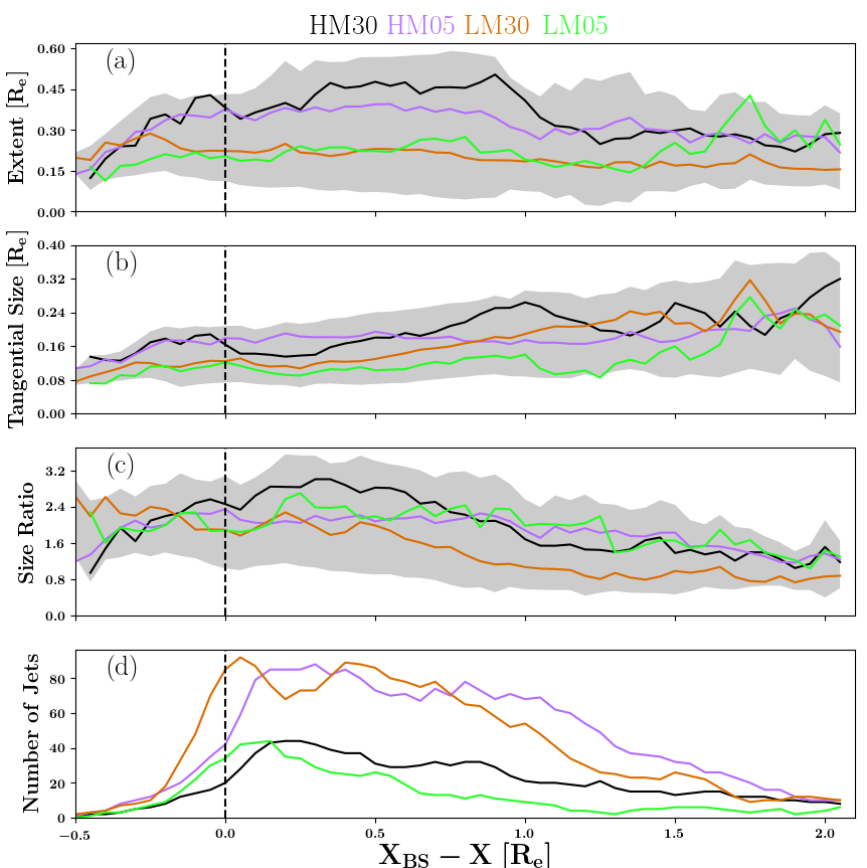
Figure 8. Superposed epoch study of the (a) extent, (b) tangential size, (c) size ratio (defined as in Fig. 7c), and (d) number of jets as a function of the jet average centre position (red dot in Fig. 1a and b) relative to the bow shock. The different colours refer to the superposed epoch averages from the different runs, identified with a run identifier (see Table 1): orange and green (black and purple) are the low (high) M A runs, respectively. Grey shows standard deviations subtracted and added to the average, taken from all